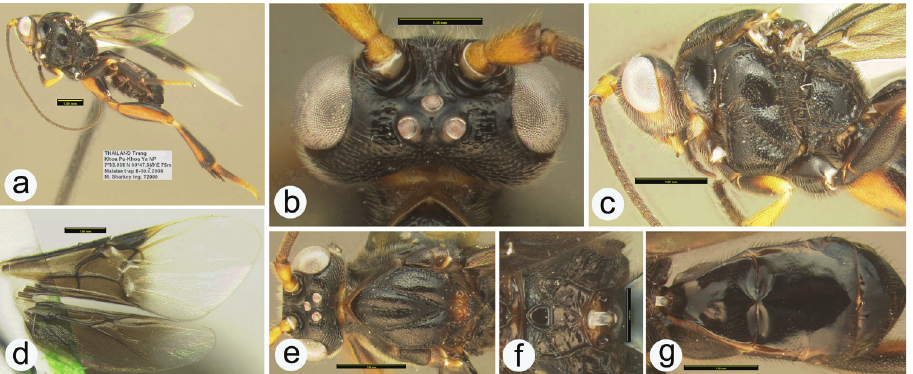
Figure 14. Zelodia ratanae sp.n. a lateral habitus b dorsal head c lateral head and mesosoma d wings e dorsal head and mesosoma f dorsal propodeum g dorsal